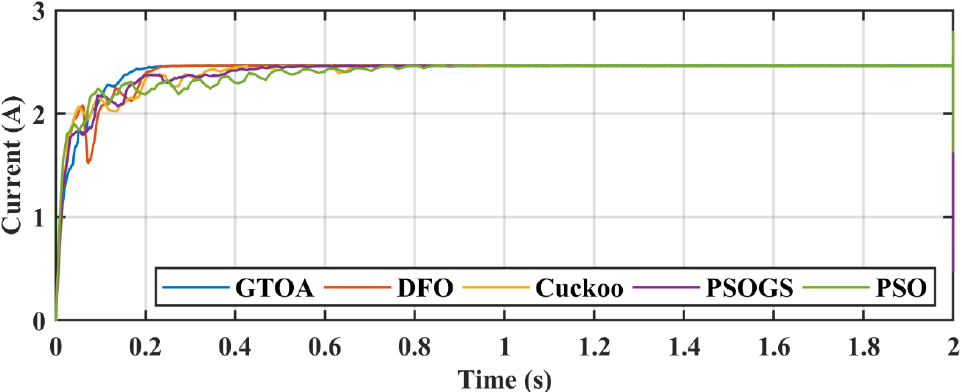
Figure 19. Comparison of voltage transients of GTOA.